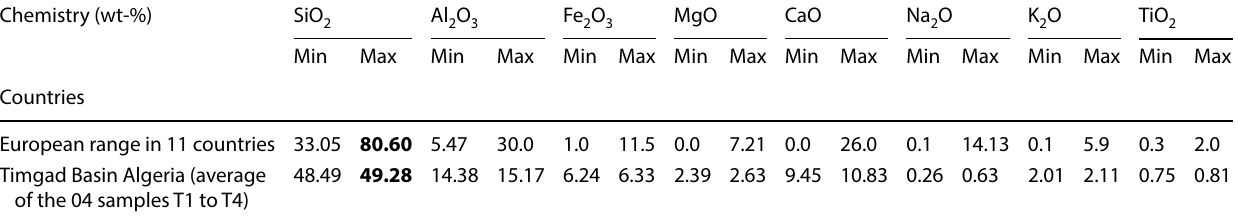
Countries European range in 11 countries 33.05 80.60 5.47 Timgad Basin Algeria (average of the 04 samples T1 to